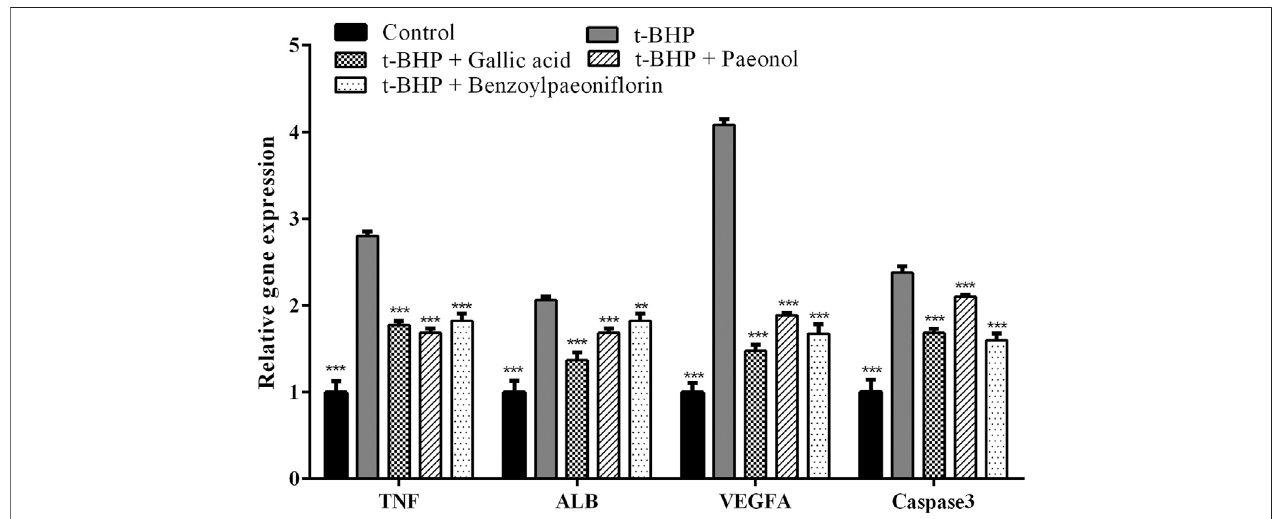
FIGURE 8 | The expression patterns of target genes in RAW264.7 macrophages treated with gallic acid, paeonol and benzoylpaeoni fl orin. The relative gene expressions were evaluated by qRT-PCR. Compared with t-BHP treatment cell group, *** p < 0.001; ** p < 0.01; * p < 0.05.